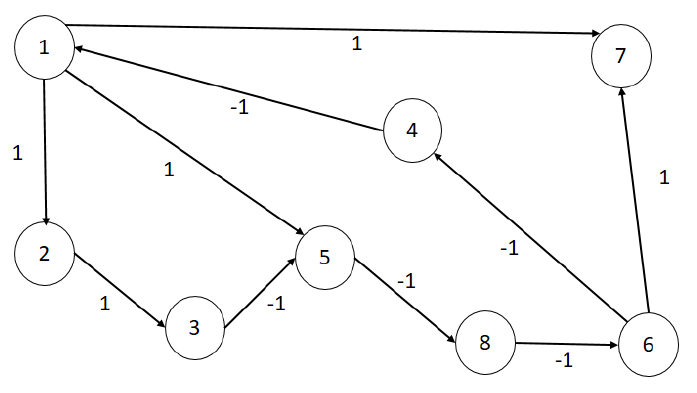
Figure 5. Structurally unbalanced directed signed graph.